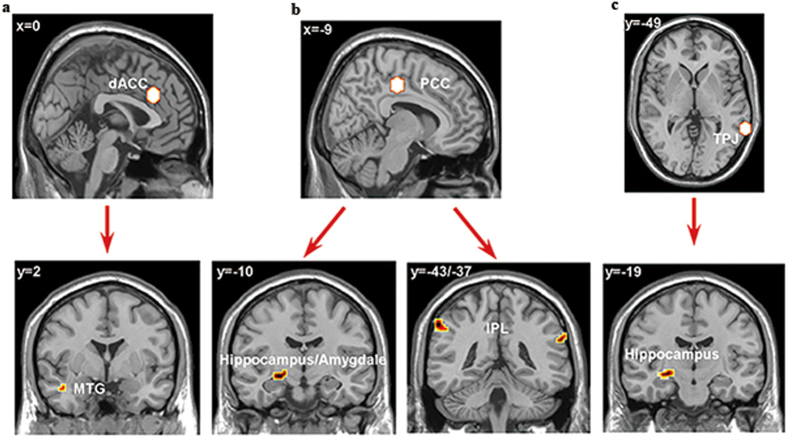
gPPI results.(a) The dACC seed had increased functional connectivity with MTG for the f3 + f4 condition. (b) The PCC seed had increased functional connectivity with bilateral IPL and hippocampus/amygdala for f3 + f4 condition. (c) The TPJ seed had increased connectivity with hippocampus for f3 + f4 condition (p < 0.001, small volume corrected).